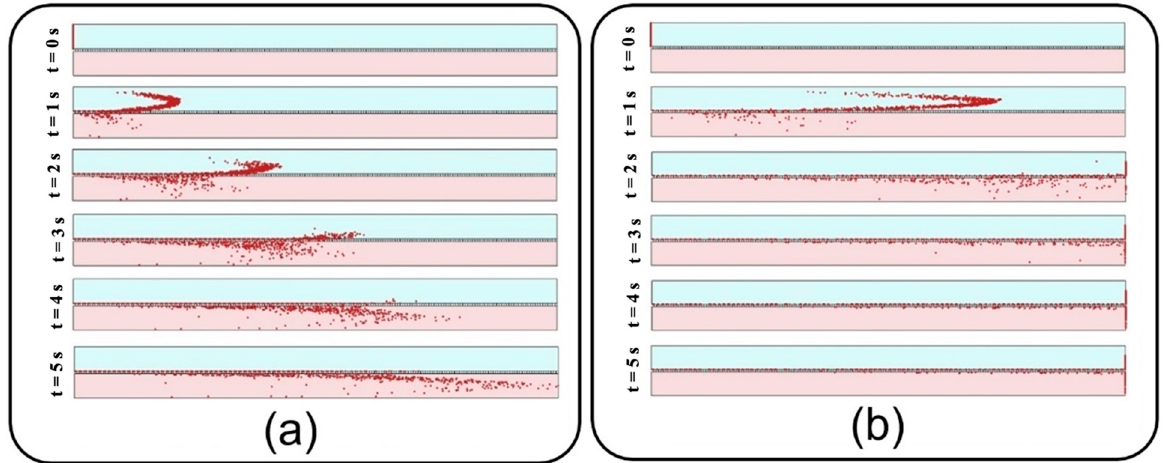
Figure 11. Snapshots from transient distribution of NPs with a diameter of 900 nm in the lung-on- a-chip device with pore diameter and pore-to-pore distance of 10 µm under the fluid velocity of ( a ) 0.3 mm/s, and ( b ) 1 mm/s.